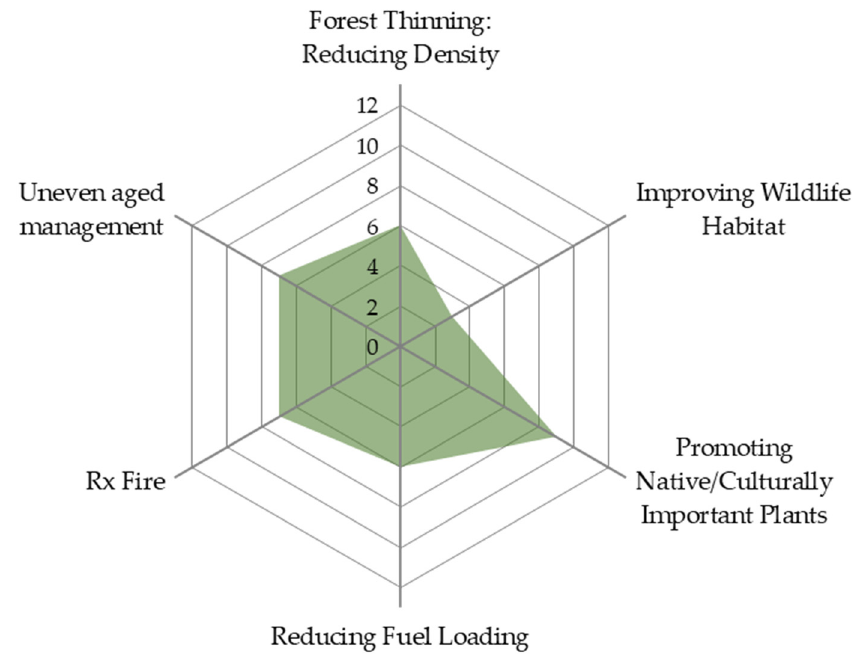
Figure 4. Within the subtheme of “Active Management”, this graph indicates the number of participants who spoke about each management activity. For example, the subtheme ‘promoting native/culturally important plants’ was talked about by 9 participants.